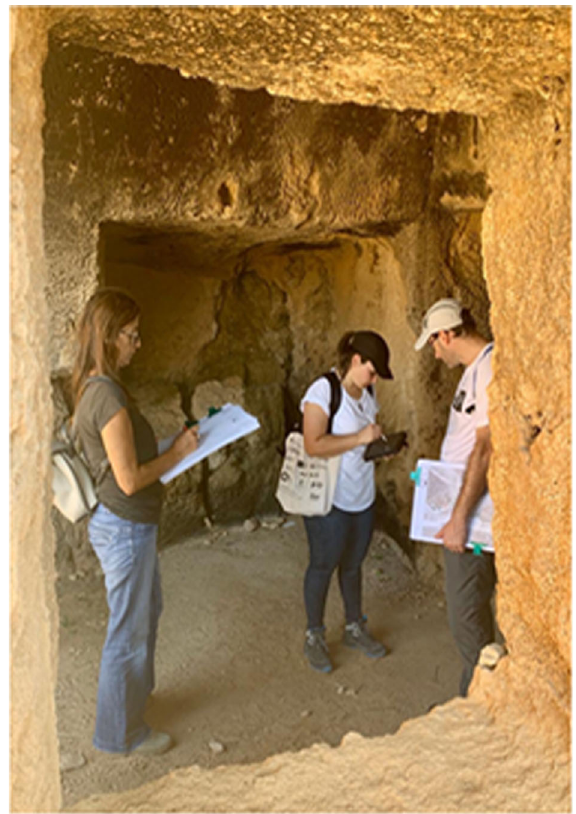
Fig. 17 CIMS and DoA teams collaborating in documenting the site, integral part of training efforts (Source: the